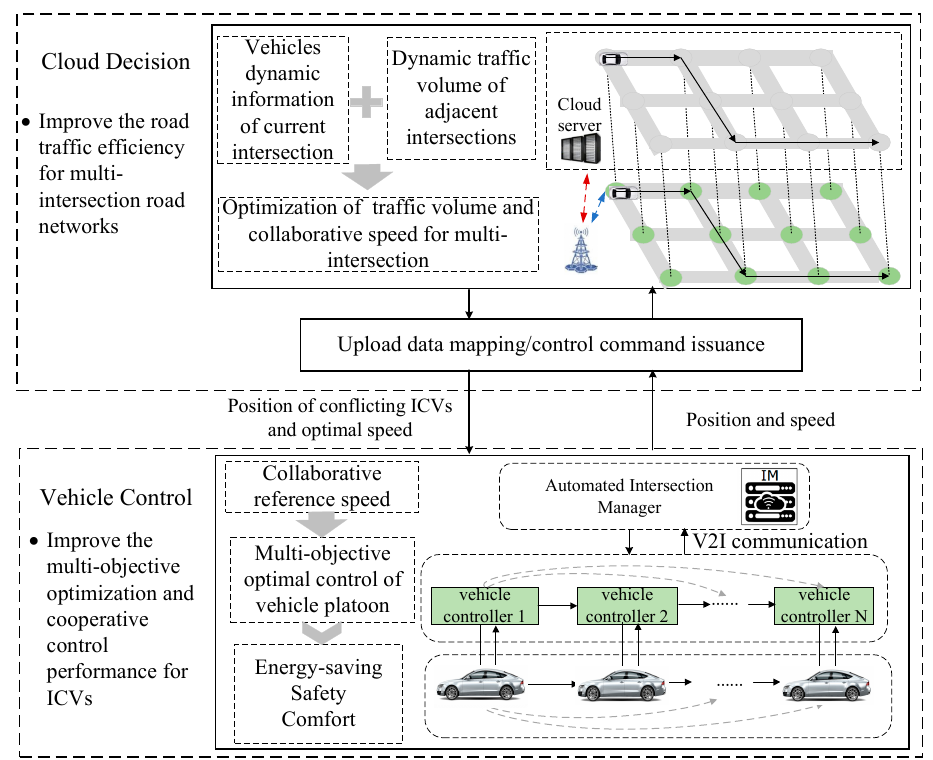
Figure 1. Distributed and hierarchical optimal control architecture.